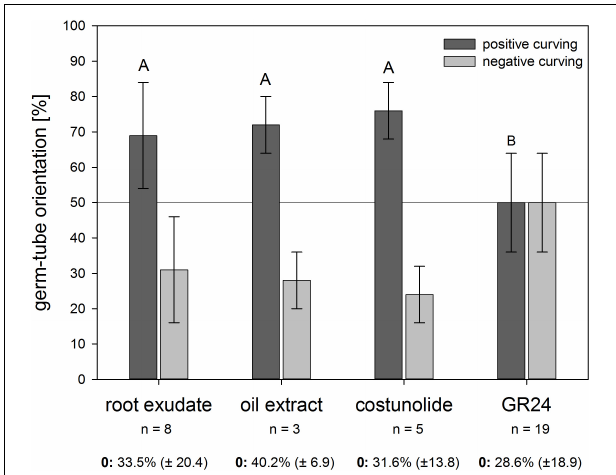
FIGURE 3 | Reaction of O. cumana germ tubes on sunflower root exudate, sunflower oil extract, costunolide (23 ppm, 10 − 4 M), and GR24 (1 ppm, 3.3 × 10 − 6 M) as substance sources. Percentage ± standard deviation ( n = 3–19 biological experiments) of positive ( dark gray ) and negative ( light gray ) reacting germ tubes are presented in the histogram. Germ tubes without clear orientation were not included in the calculation of the positive vs. negative reactions, but the percentage ± standard deviation of this “zero group” (0) is given below the histogram of each sample. Experiments with STLs containing samples of sunflower root exudate, sunflower oil extract, and costunolide resulted in significantly higher percentages of positive than the negative reactions compared with GR24 (Tukey test, p < 0.05, same letter indicates that differences are not statistically